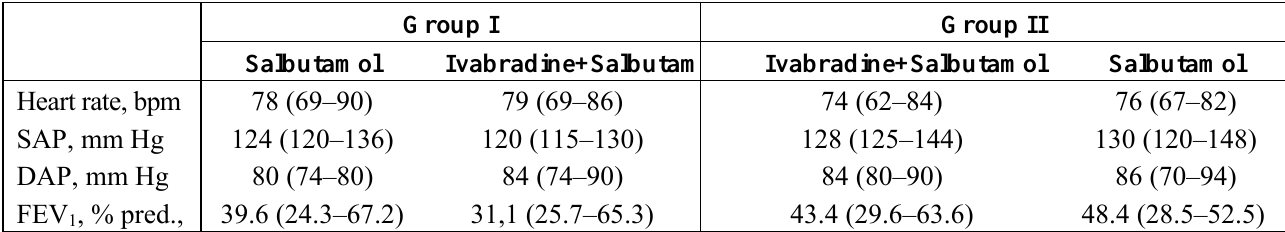
Table 2. Baseline characteristics of randomized groups of